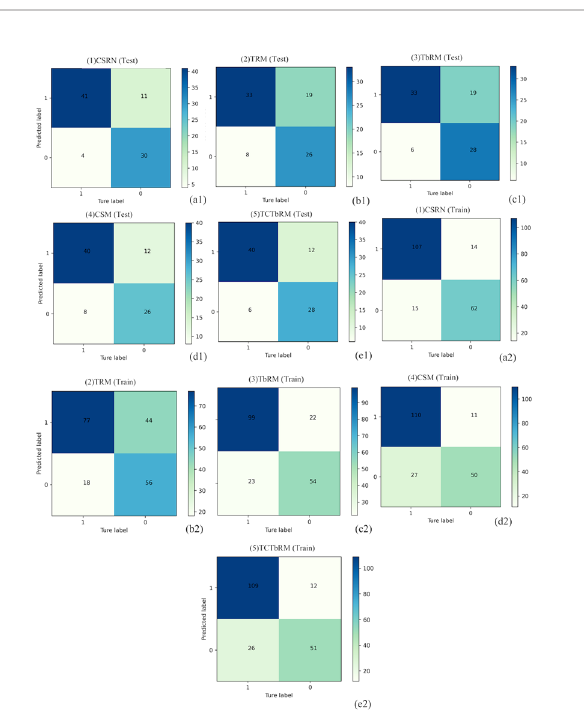
FIGURE 7 | Confusion matrixes of the fi ve models. Test set: CSRN (A1) , TRM (B1) , TbRM (C1) , CSM (D1) , and TCTbRM (E1) ; training set: CSRN (A2) , TRM (B2) , TbRM (C2) , CSM (D2) , and TCTbRM (E2) . CSRN, clinical semantic and radiomics model/nomogram; TRM, tumoral radiomics model; TbRM, tumor-to- brain interface radiomics model; CSM, clinical semantic model; TCTbRM, tumor combined tumor-to-brain interface radiomics